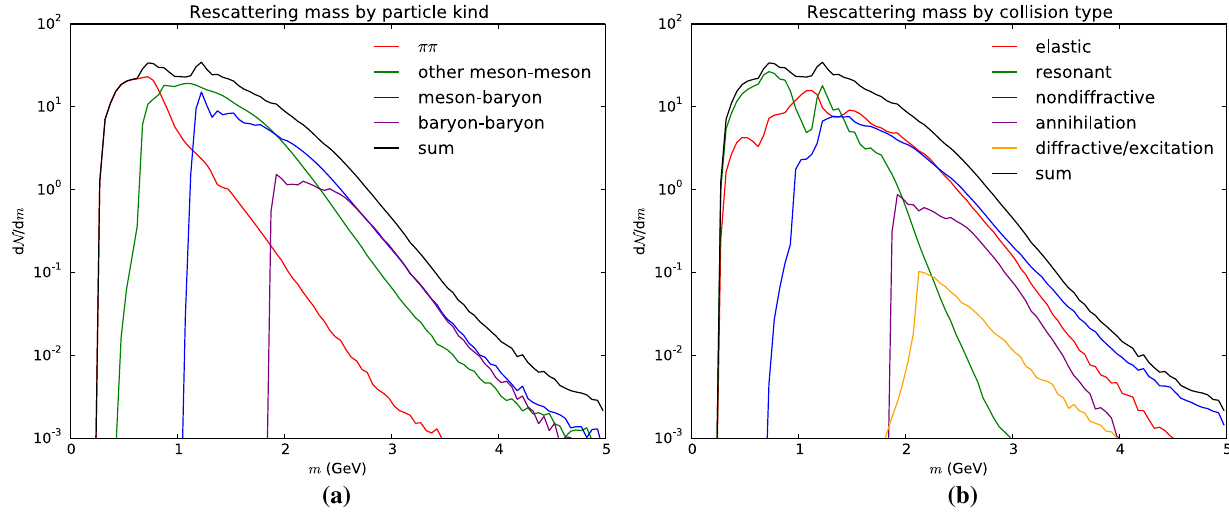
Fig. 13 Invariant mass distributions of rescattering pairs in 13 TeV nondiffractive pp events. a Grouped by incoming hadron kinds. b Grouped by process type. Line wobblings at low masses are caused by thresholds and the resonance structure, and only in the high-mass tails by limited statistics Table 11 List of model choices and parameters used to study the range of possible rescattering effects, with their effect on the rescattering rate. Parameter names are as defined in the Pythia user interface. See